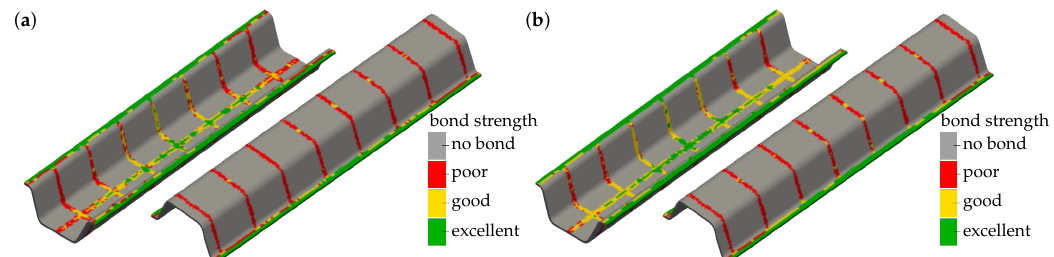
Figure 15. Quality/Decision support for sample 31. ( a ) Numerical result of full-scale simulation; ( b ) predicted result by Random